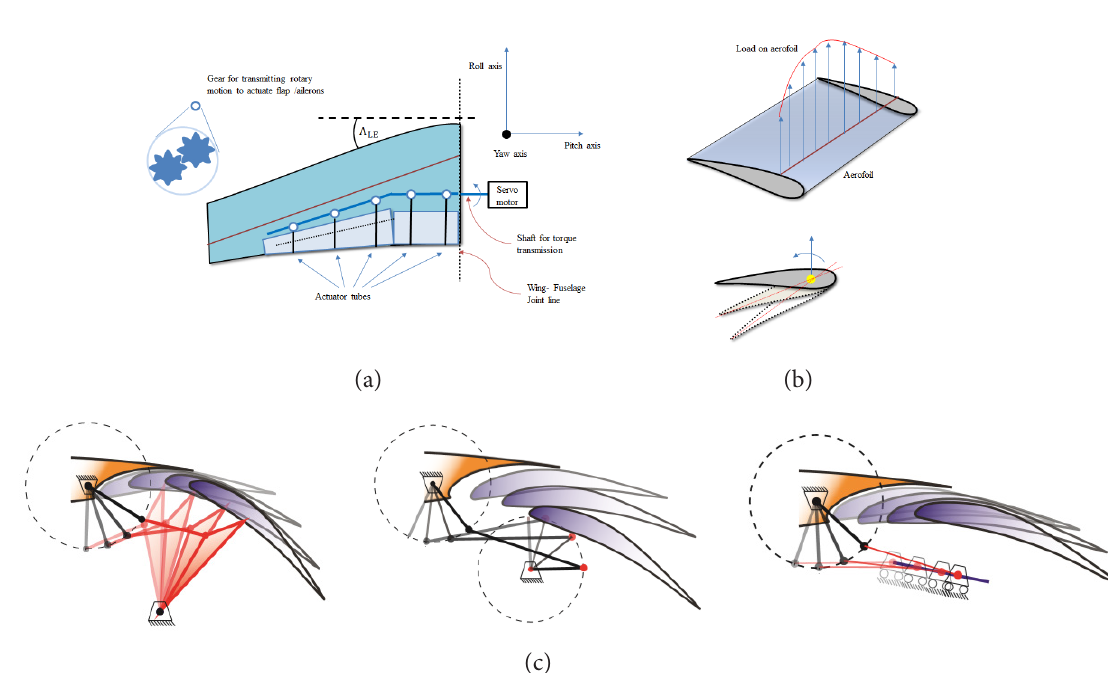
Figure 7. Illustration of (a) trailing edge flap actuation for a wing (b) aerodynamic loading action along quarter chord point of wing and flap motion about a hinge (adapted from Zaccai et al., 2016) (c) types of trailing edge flap kinematic mechanisms (Bertels,